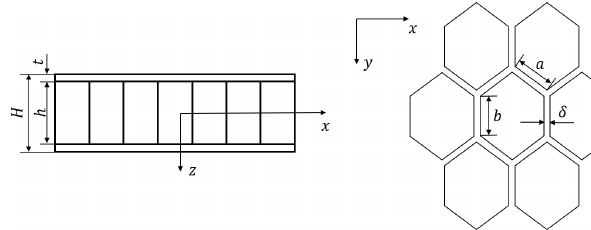
Figure 1. Honeycomb sandwich panel.